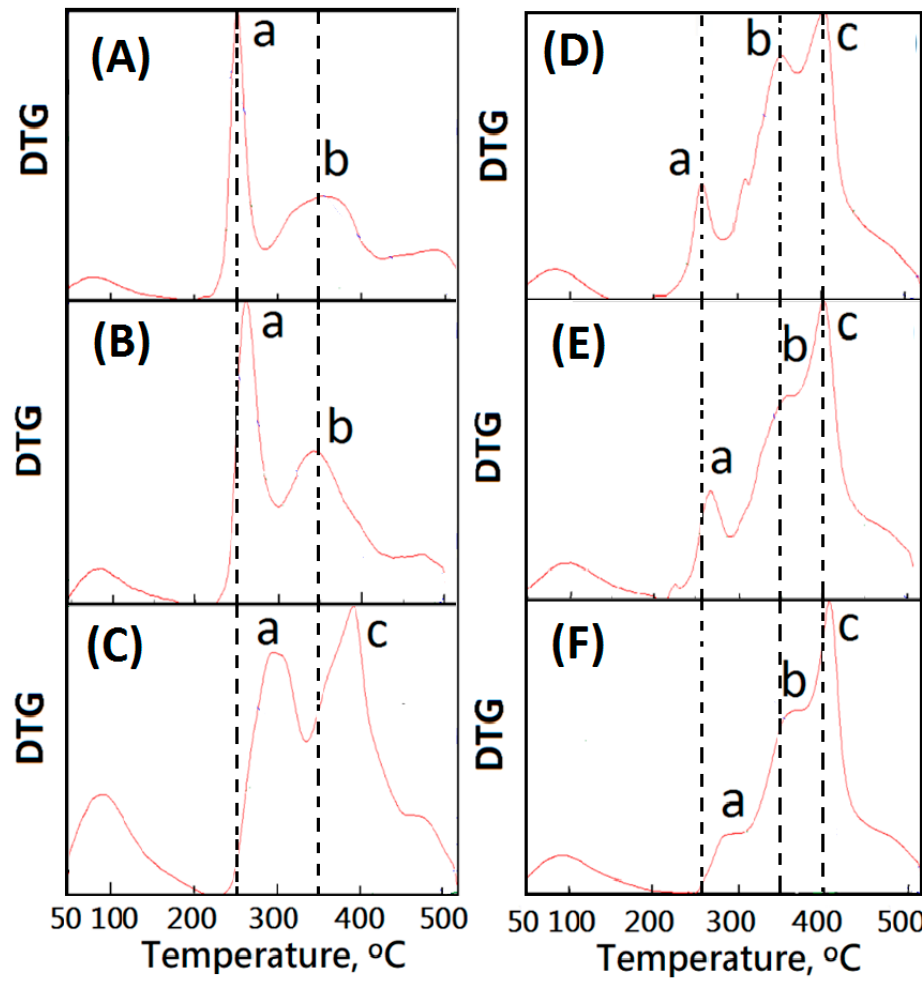
Figure 5. DTG curves of the composite scaffold membranes cross-linked with various concentra- tions of CaCl 2(aq) : ( A ) AdE1N(0 wt%), ( B )AdE1L(1 wt%), ( C )AdE1H(5 wt%), ( D ) AdE4N(0 wt%), ( E ) AdE4L(1 wt%), and ( F ) AdE4H(5 wt%).